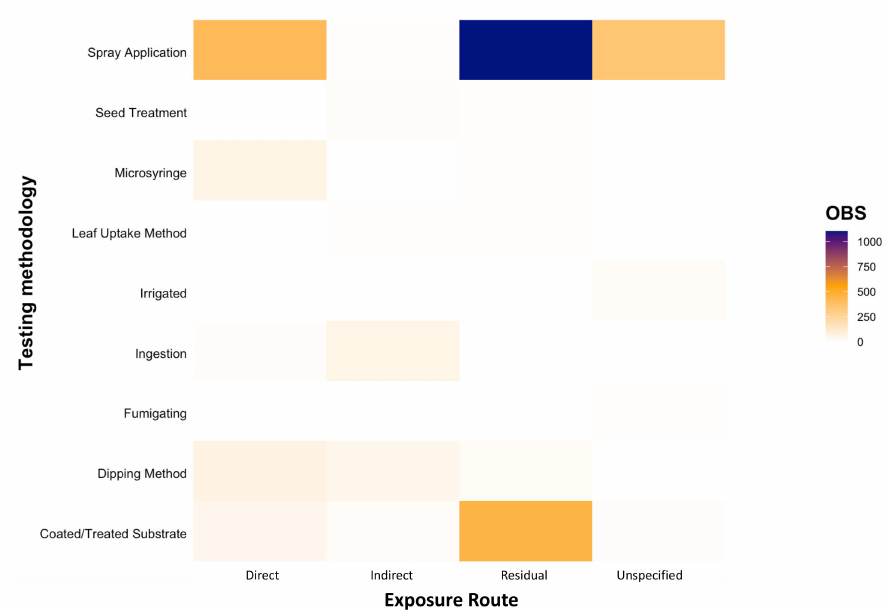
Figure 5. The number of entries (OBS) that used different methodologies and chemical exposure routes (direct, indirect, residual, or unspecified contact) when testing the toxicity of chemical Modes of Action against natural enemies relevant to the Australian grains